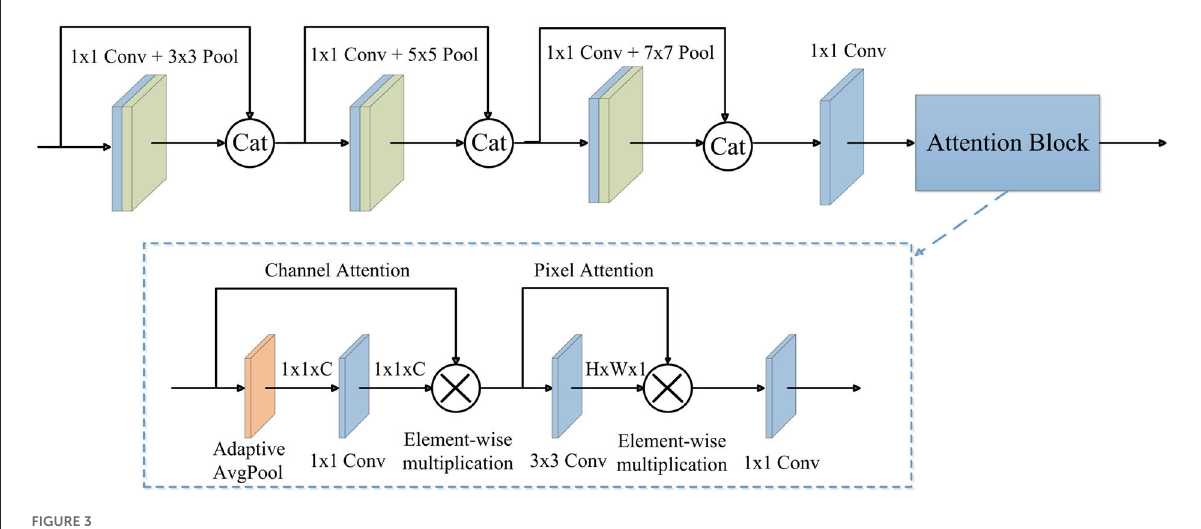
FIGURE3 The structure of AGFEB. Cat, channel-wise